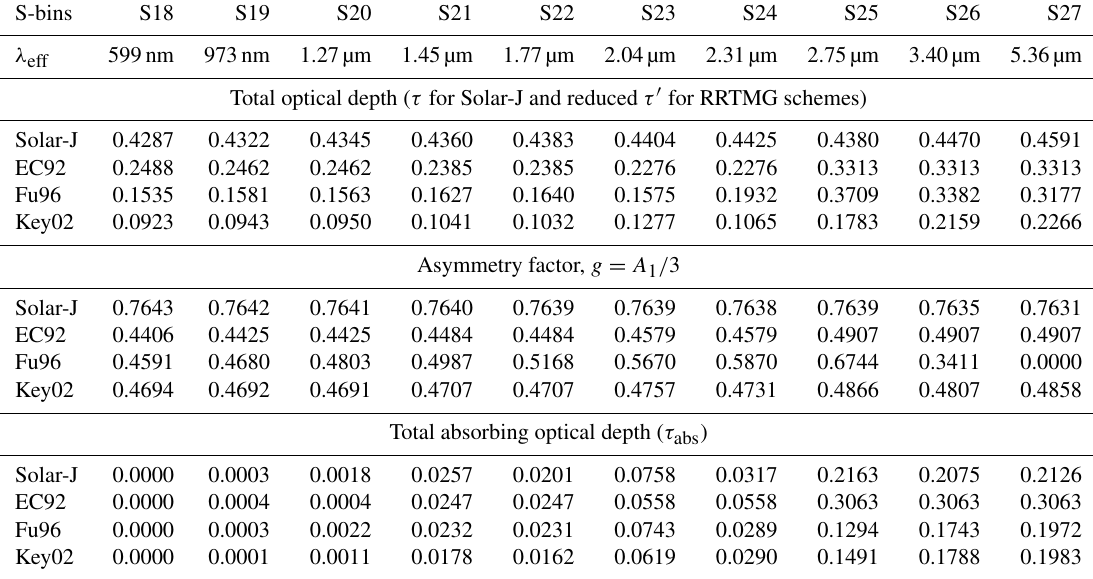
Table 6. Cirrus ice cloud optical properties: total optical depth τ for Solar-J and delta-scaled τ (cid:48) for RRTMG-SW, asymmetry factor g , and absorption optical depth, τ abs , for bins S18 to S27. See Table 1 for wavelength ranges and RRTMG-SW-equivalent